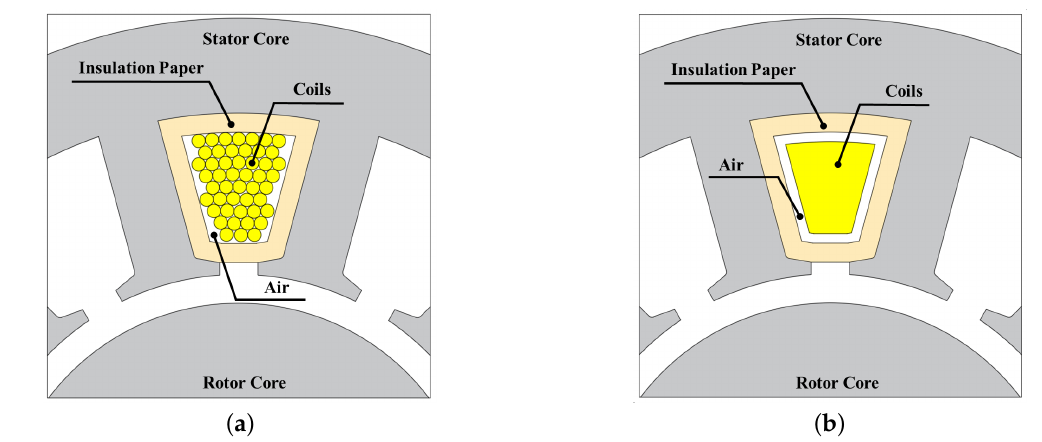
Figure 3. Reconstruction of the internal slot structure to calculate the parasitic capacitance. ( a ) Practi- cal slot structure. ( b ) Internal slot structure with a uniform air layer.